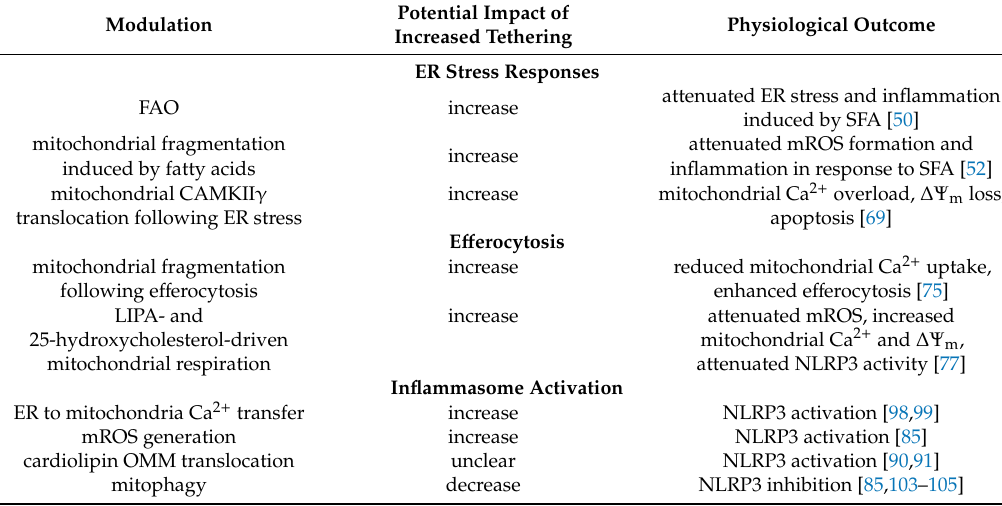
Table 2. Potential impact of ER-mitochondrial tethering in